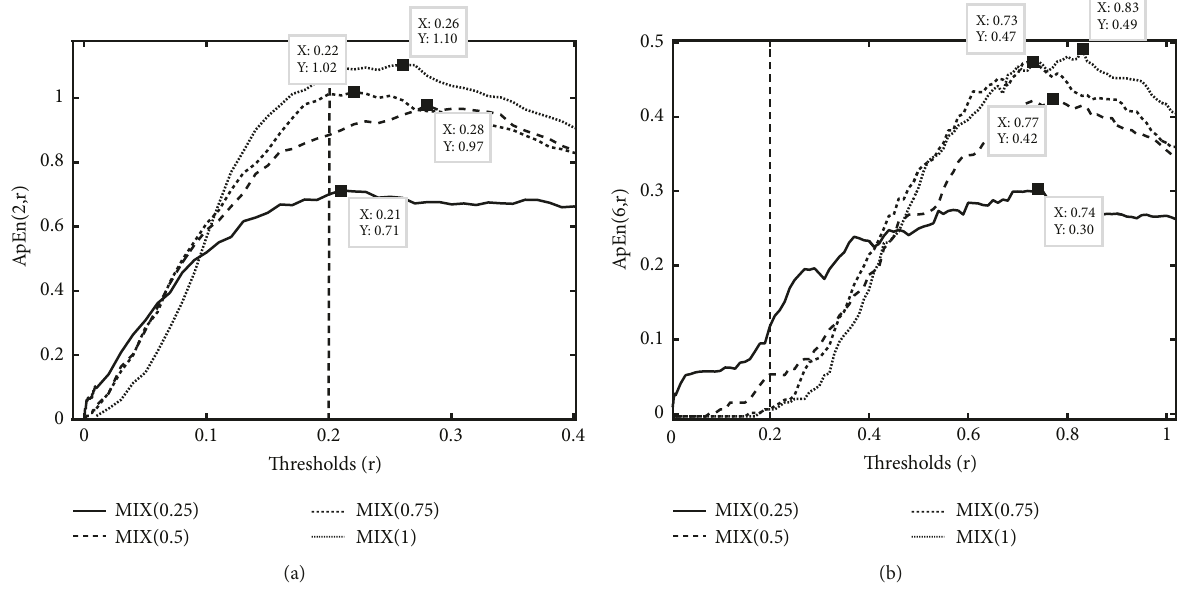
Figure 3: Approximate entropy values computed over MIX( P ) processes considering a set of thresholds and evaluatedfor m = 2 (a) and m = 6 (b) for a particular stochastic realization. Dashed line indicates r = 0.2 in both panels. ApEn(2,r values are displayed for each case.